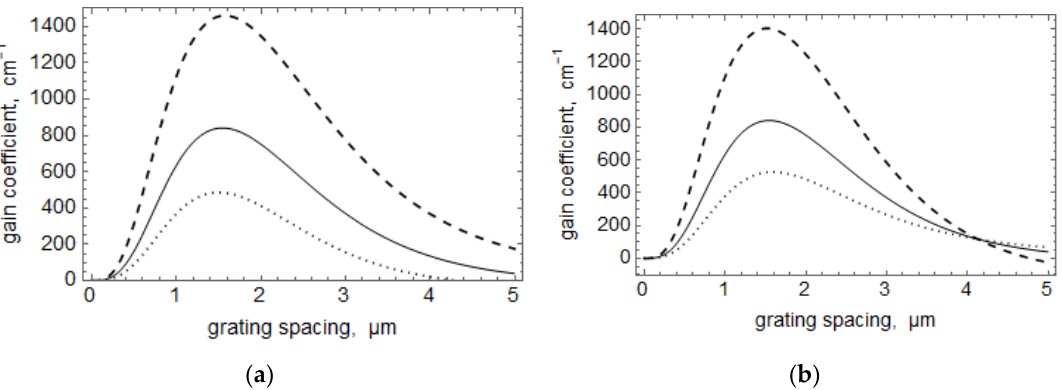
/ e K = 1; ( b ) / e K = 0.1 (dotted), 1 (solid), 3 (dashed), 3 3